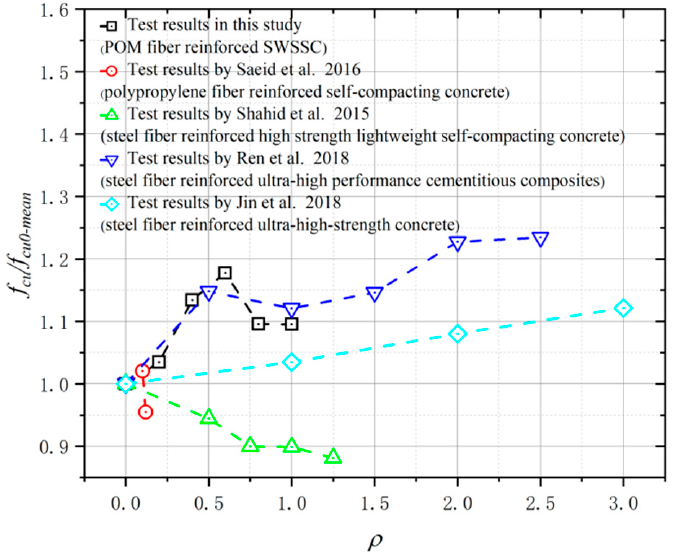
Figure 11. Comparison of compressive strength between POM-SWSSC and other types of fiber-reinforced concrete [58–61].